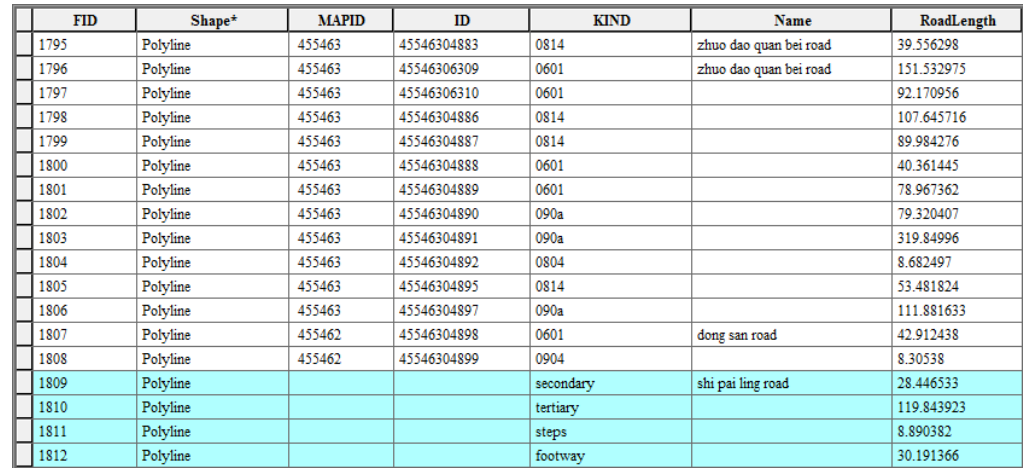
Figure 12. New OSM roads added to the attribute table of the updated reference roads (subset 3).